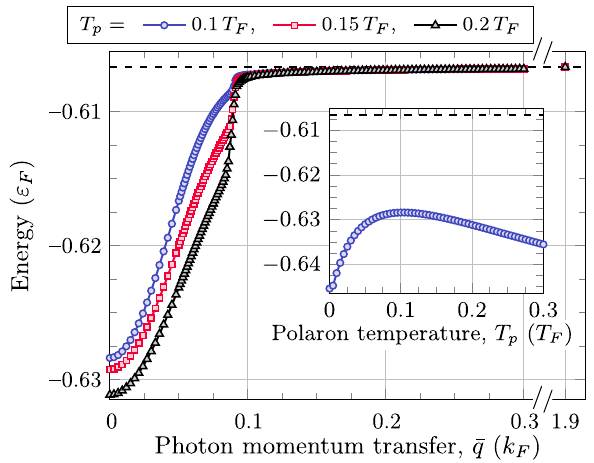
FIG. 9. Coherent spectral peak position at unitarity. Using the full many-body model for the Raman spectra [first term of Eq. (20)], we plot the coherent peak position versus transferred photon momentum for polaron temperatures T p ¼ 0 . 1 T F (blue circles), 0 . 15 T F (red squares), and 0 . 2 T F (black triangles) at ð k F a Þ − 1 ¼ 0 with n I ¼ 0 . 15 n . We observe convergence to the − 0 . 6066 ε zero-temperature value ϵ F (dashed line) for pho- pol ¼ ton momentum transfer larger than 0 . 1 k F . Specifically, with Raman spectroscopy in our experiment ( ¯ q ¼ 1 . 9 k F ), no shift is expected. Inset: temperature dependence of the spectral peak position with conventional rf spectroscopy ( ¯ q ¼ 0